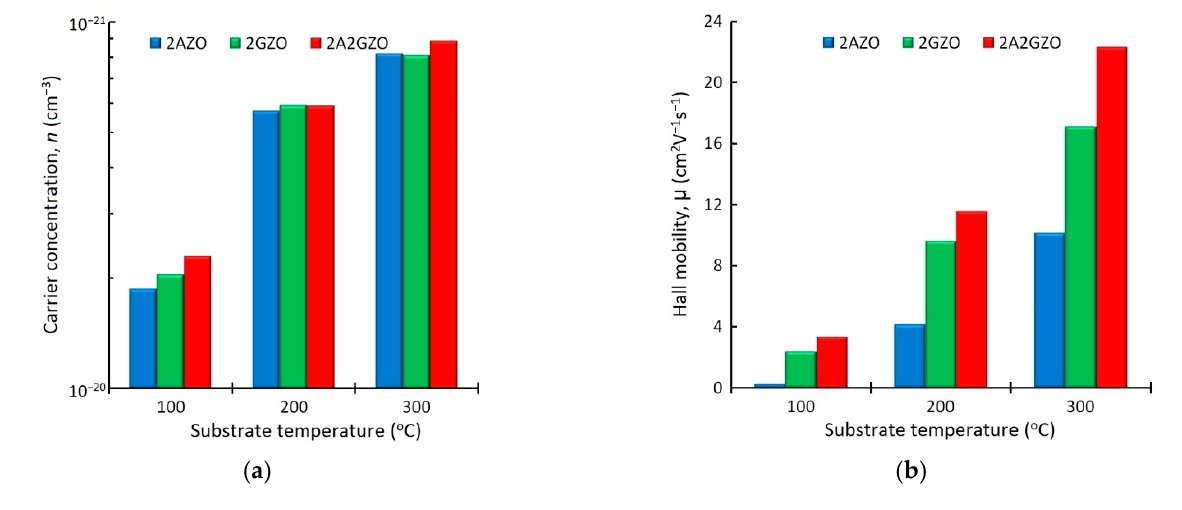
Figure 2. ( a ) Carrier concentration of single-doped 2AZO and 2GZO thin films and co-doped 2A2GZO thin films as a function of substrate temperature; ( b ) Hall mobility of single-doped 2AZO and 2GZO thin films and co-doped 2A2GZO thin films as a function of substrate temperature.